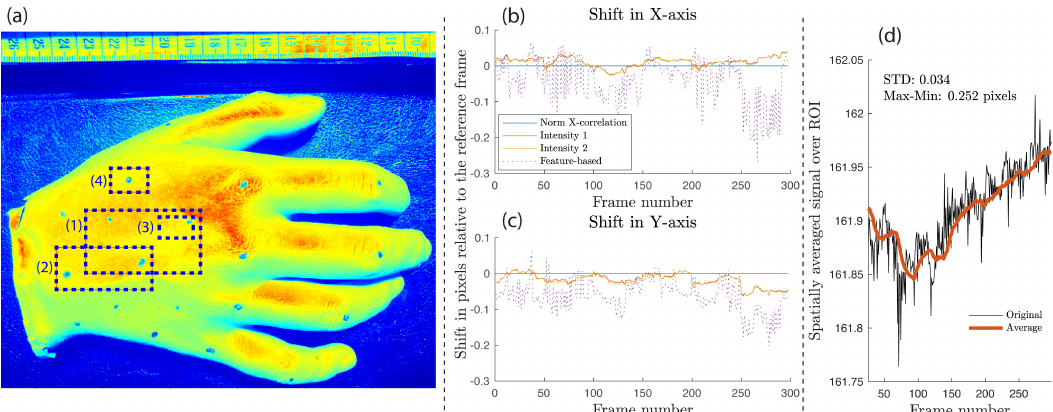
Figure 7. ( a ) Prosthetic palm replica with pixel intensity plotted in pseudo colors for better contrast. Regions of interest (ROIs 1–4) of various sizes were selected. Additional markers were added on the surface to test performance of feature-based image registration methods. Resolution was set at 74 pixels/cm. ( b , c ) Image shift along X -axis and Y -axis of a static silicone palm (ROI 1) should be zero, but sub-pixel variations for the intensity- and feature-based methods are clearly visible. ( d ) A spatially averaged signal extracted from a static ROI 3, with no registration applied, shows a deviation from its DC level, most likely due to the quantization noise and light source intensity